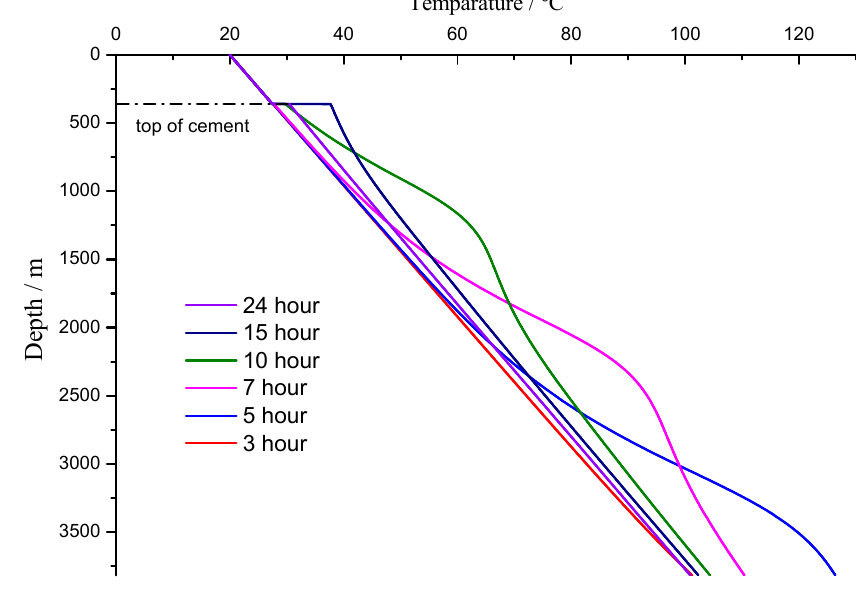
Figure 9. Transient distribution of cement temperature in the